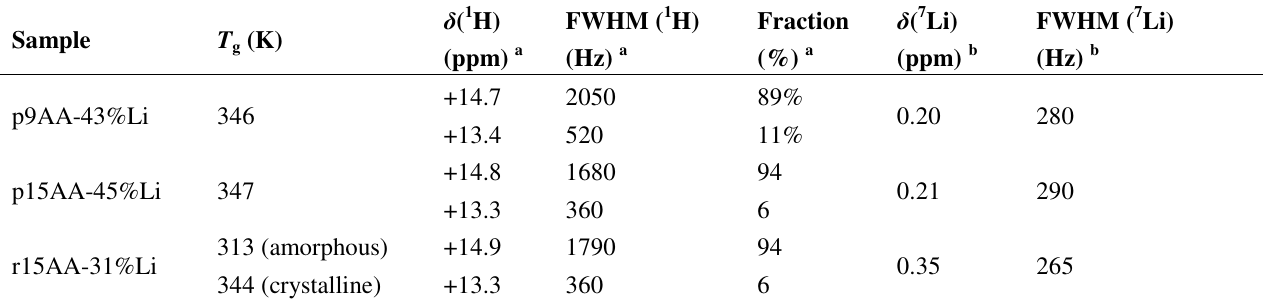
Table 1. 1 H and 7 Li magic angle spinning (MAS) nuclear magnetic resonance (NMR) chemical shifts, line widths, and relative fractions of the acid proton and lithium environments in the random and precise Li-neutralized P(E-AA) ionomers. Sample T (K) g